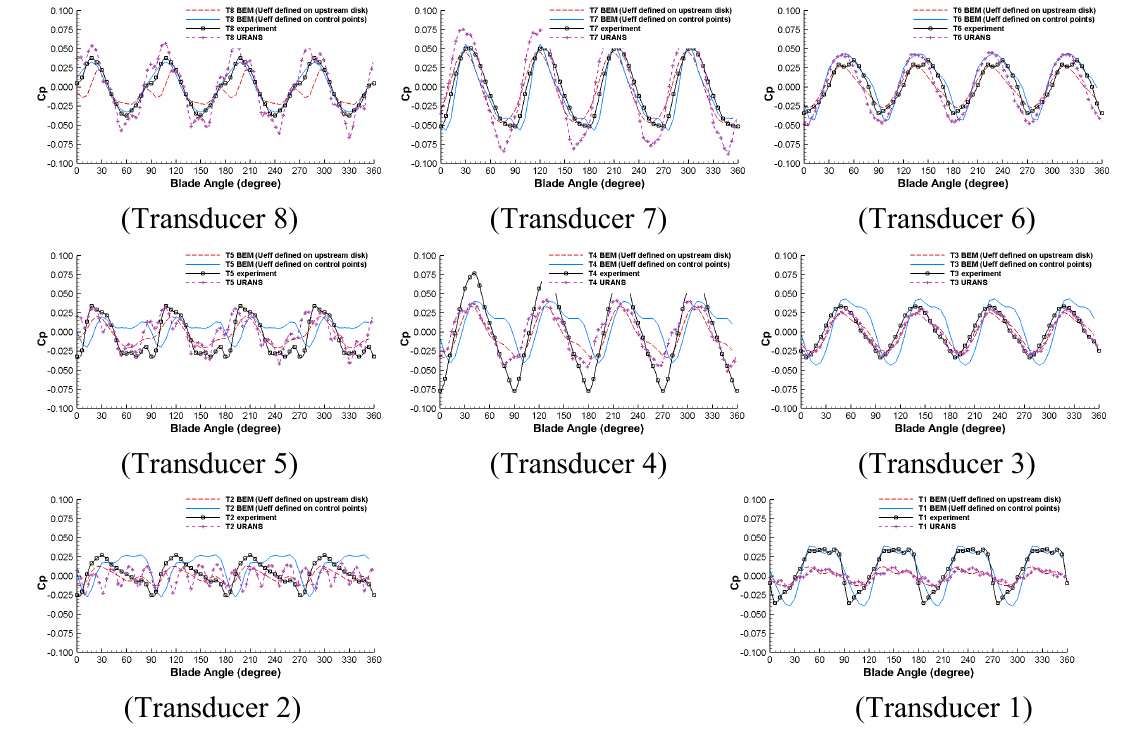
Figure 12. Comparison of hull pressures predicted by the pressure-BEM solver with different treatment of the effective wake field: (a) Effective wake field is evaluated at the center of every blade BEM panel (blue solid line); (b) The effective wake field is extrapolated to the upstream curved surface close to the blade leading edge (red dash line).